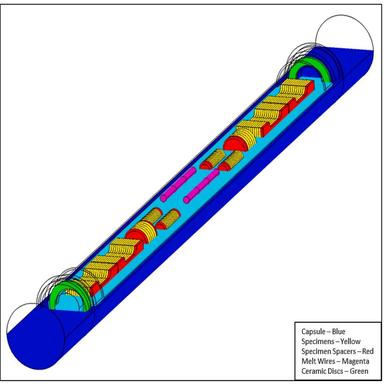
Depiction of the COMSOL model.